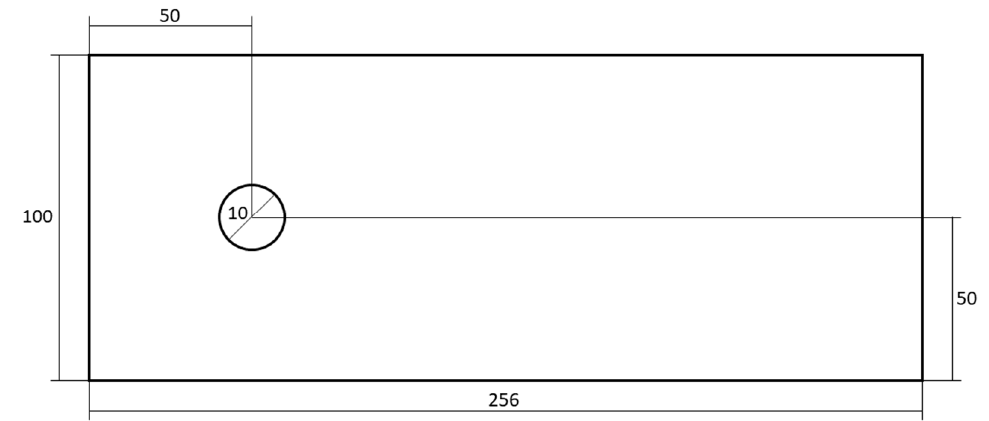
Figure 1. Computational domain (not to scale).